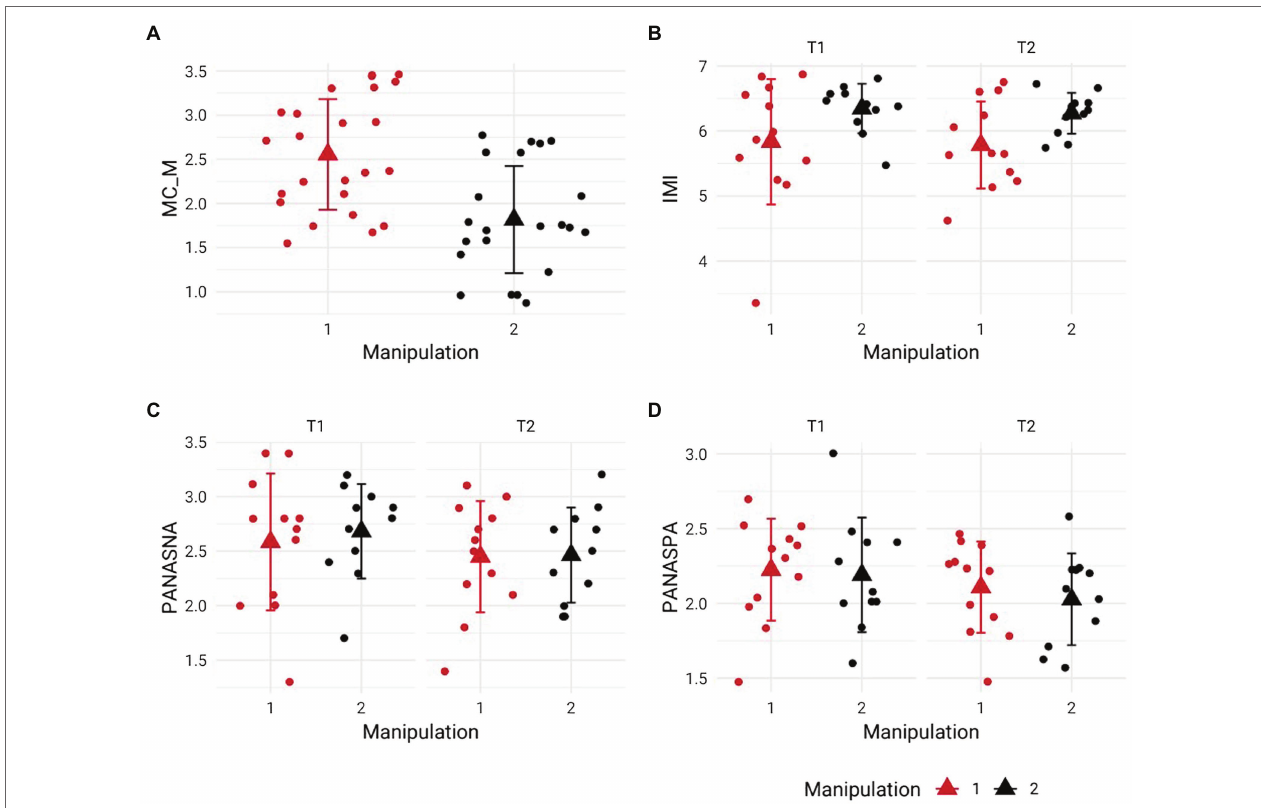
FIGURE 1 | The experimental manipulation (depicted in red) was perceived as more self-control demanding than the control condition (depicted in black) (A) but did neither affect the motivation to complete the shooting task (B) , nor did it lead to changes in negative (C) and positive (D) affect. Error bars represent standard